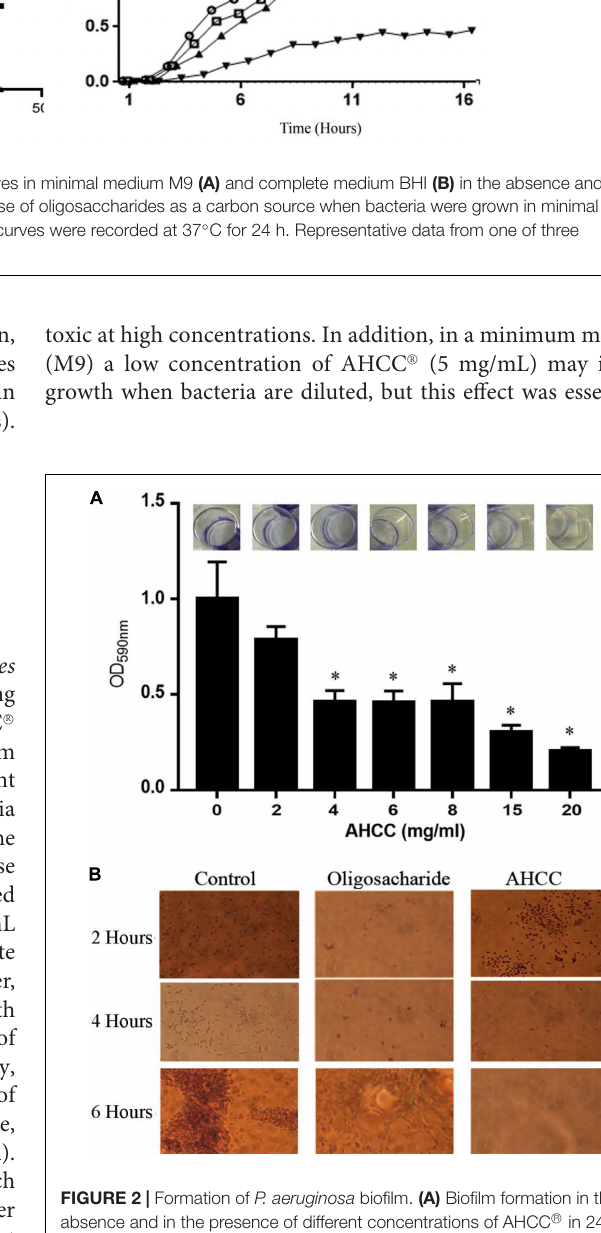
Frontiers in Microbiology |